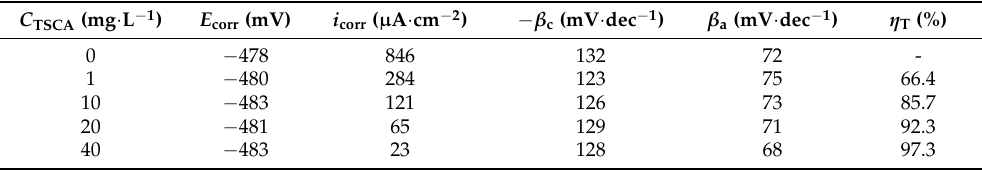
Table 3. Polarization parameters and corresponding inhibition efficiency for carbon steel immersed in 1 M HCl solutions with different contents of